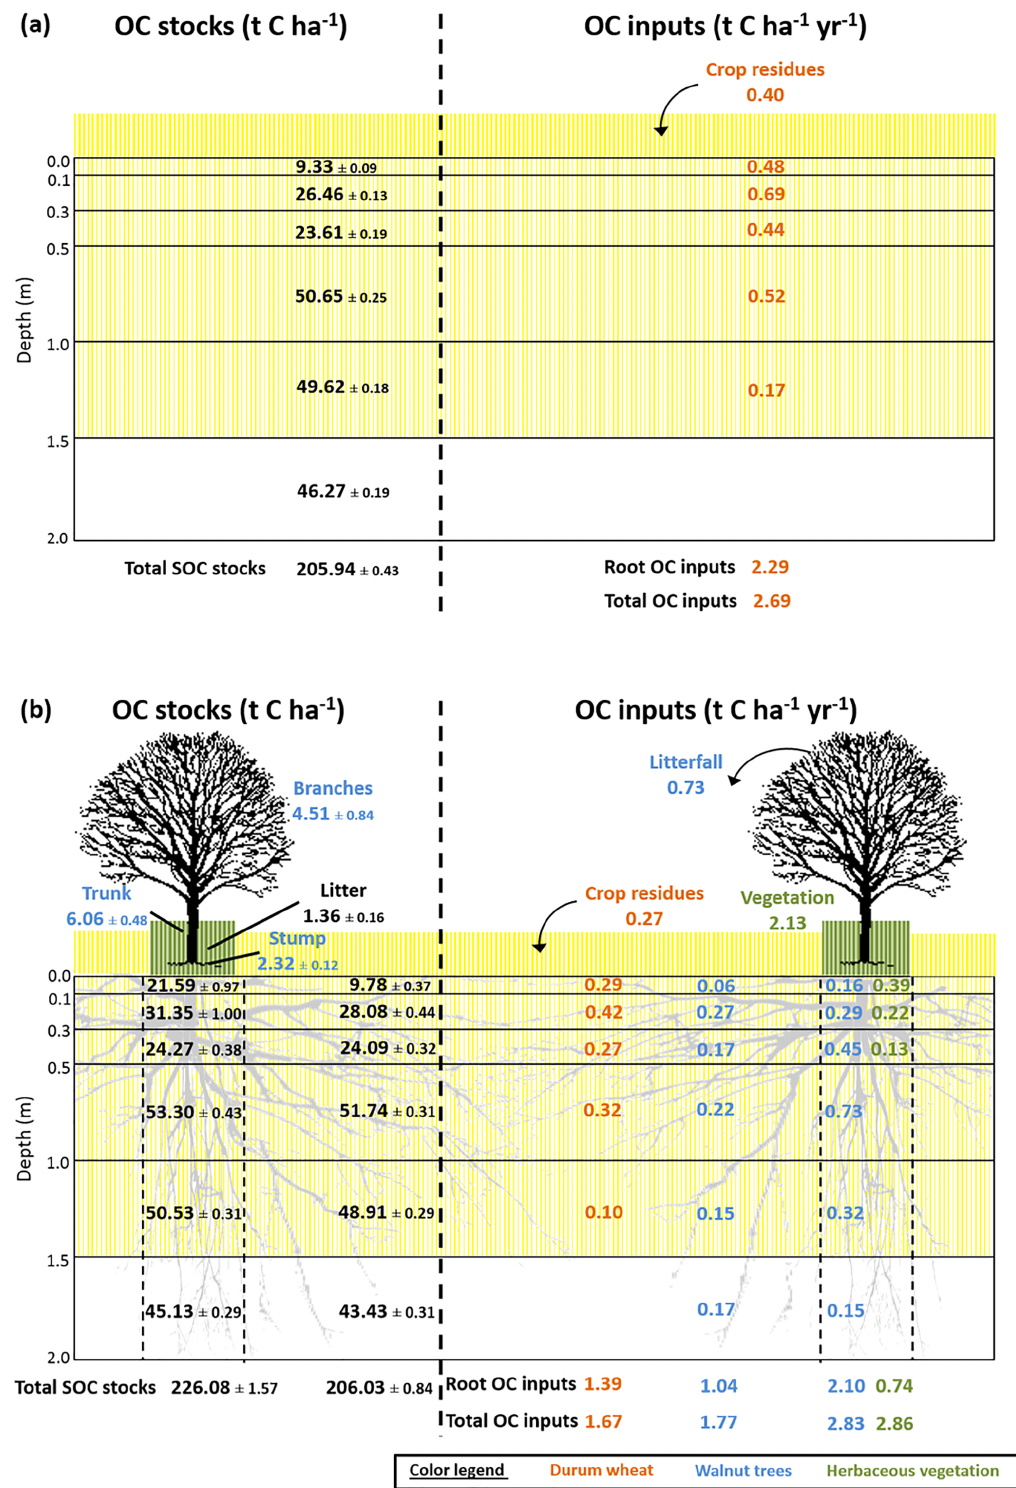
Figure 4. Measured soil organic carbon stocks and organic carbon inputs to the soil (a) in the agricultural control plot and (b) in the 18-year- old agroforestry plot. Associated errors are standard errors. Values are expressed per hectare of land type (control, alley, tree row). To get the values per hectare of agroforestry, data from the alley and tree row have to be weighted by their respective surface area (i.e., 84 and 16%, respectively) and then added up. OC: organic carbon; SOC: soil organic carbon. SOC stock data are from Cardinael et al. (2015b), and data for tree root OC inputs are combined from Cardinael et al. (2015a) and Germon et al.